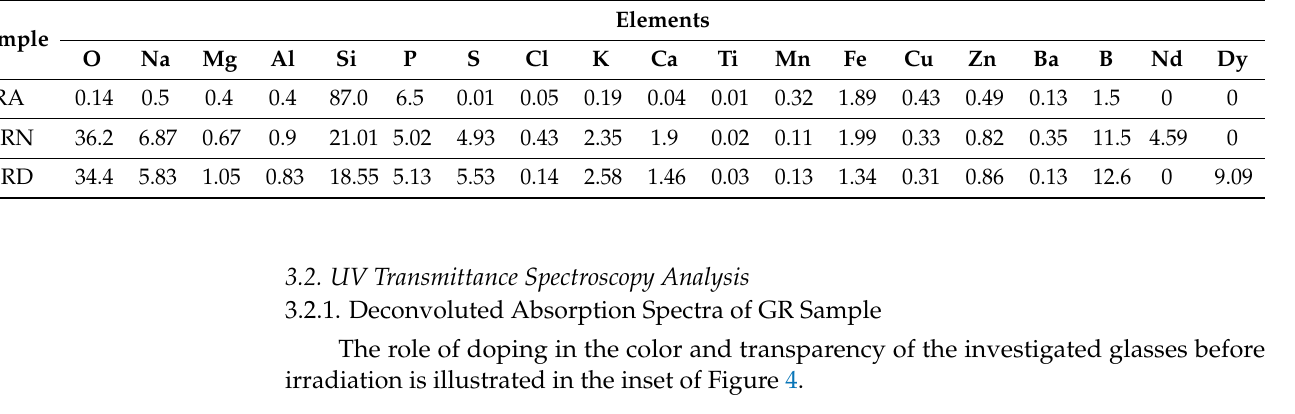
Figure 3. SEM and Elemental mapping for ( a ) GRN ( b ) GRD samples. Table 1. EDX Analysis of RA, GRN, and GRD Samples.